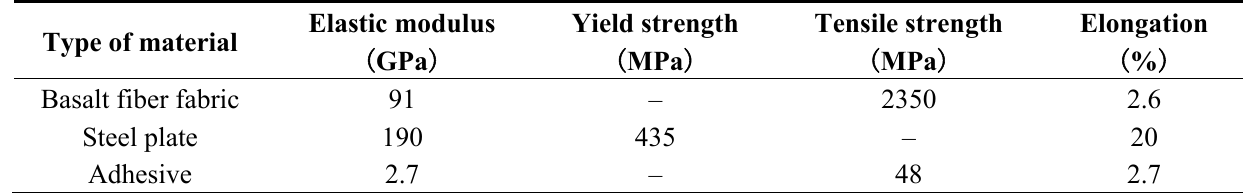
Table 1. Mechanical properties of BFRP-steel composite plate (BSP)